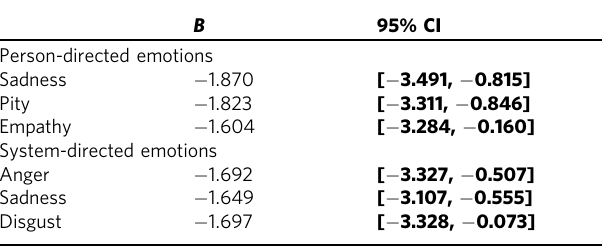
Table 4 Indirect effects of conservatism on inequality treatment effects mediated by economic system justi fi cation in Study 1.